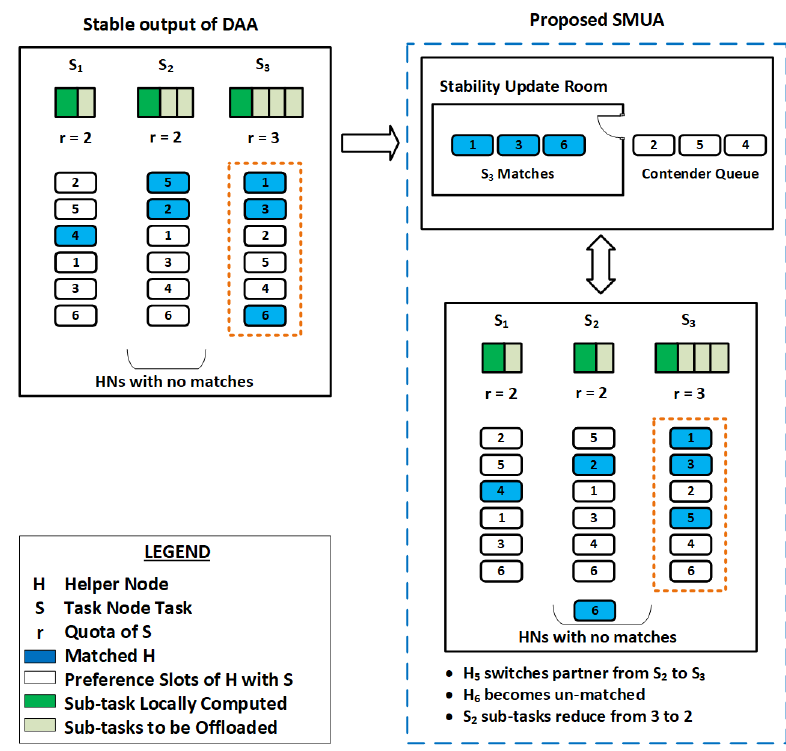
Figure 2. Proposed matching-update algorithm to solve externalities